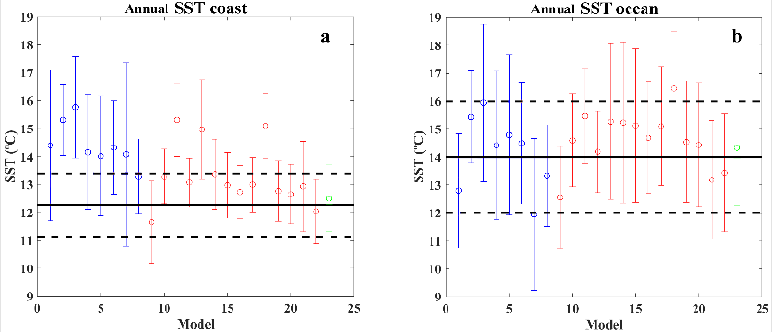
Figure 9. California upwelling system mean SST value (± 1 SD) for the OISST ¼ (black solid line) and each CMIP6 model for: ( a ) coastal and ( b ) oceanic points. The number and color of each model refer to Table 1.